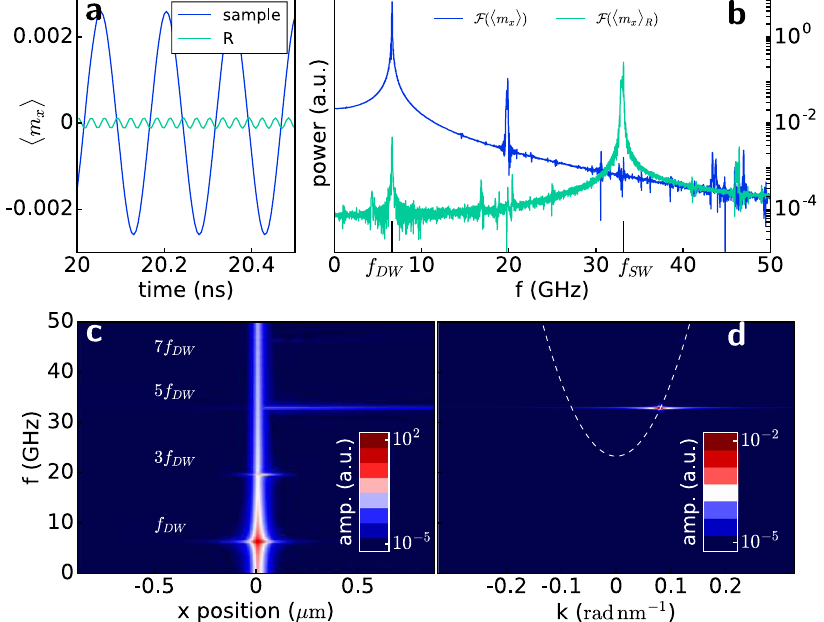
Figure 3. Study of DW rotation frequency and SW emission frequency. ( a ) Evolution of the averaged − x component of the normalized magnetization during a time window of . 0 5ns . The dark blue line shows averaging over the whole sample and the light blue line shows the averaging over the region R away from the DW. Different periodicities can be observed. ( b) Fourier transform of the time signals shown in ( a) the dark blue line shows the main peak at the frequency of rotation of the DW f DW , and the light blue line has the principal peak at the SW propagation frequency = f f 5 . ( c ) Frequency spectrum of m x ( t ) as a function of SW DW x − position at the center of the strip width. Peaks centred at the DW position with an odd multiple frequency of f DW are marked. ( d) − f k diagram extracted from the central line in region R shows a focused peak lying over the right principal branch of the analytical dispersion relation, marked as a dashed